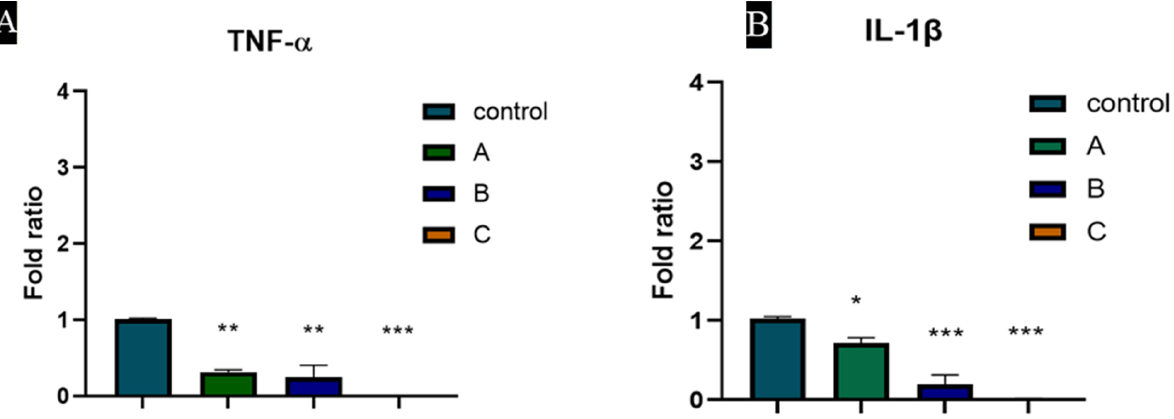
Figure 7. The expression of ( A ) TNF- α and ( B ) IL-1 β in Fibroblasts, treated with different concentrations of heparin (1 µg/mL, 5 µg/mL and 10 µg/mL).